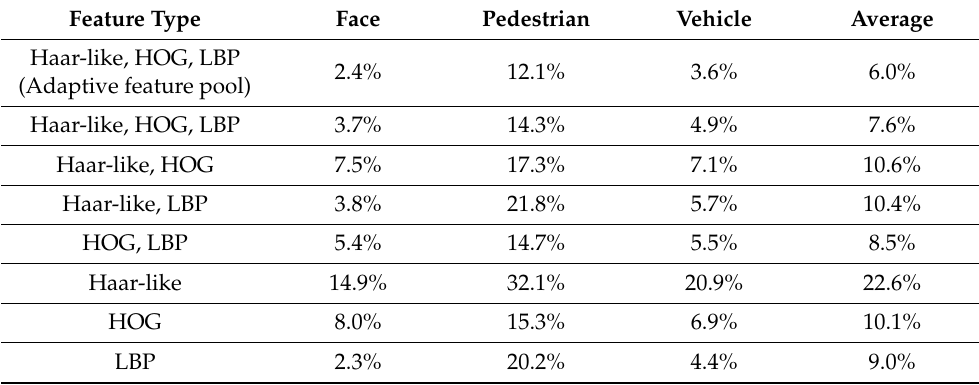
Table 1. Comparison result (error rate) of different feature